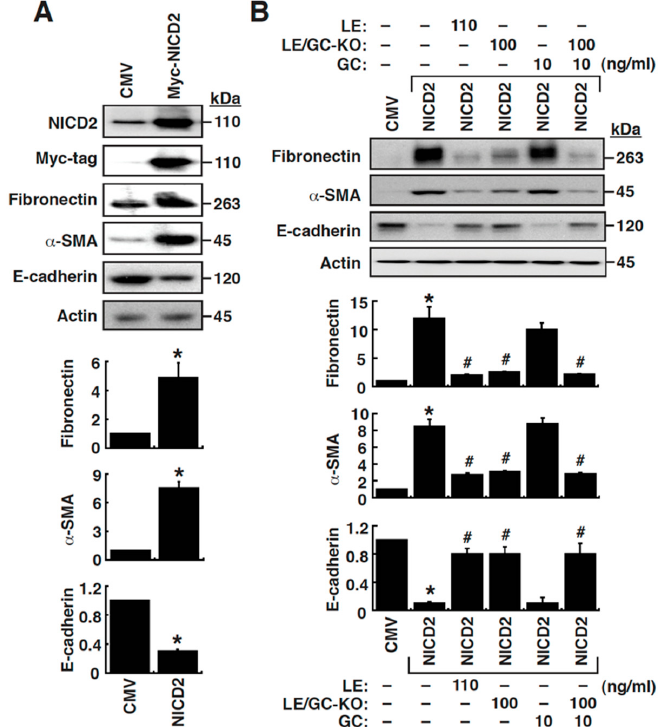
Figure 6. Overexpression of NICD2 is sufficient to induce EMT in NRK-52E cells; however, LE or LE/GC-KO can attenuate NICD2-mediated EMT. ( A ) Activation of EMT in NRK-52E cells by NICD2 overexpression. At 48 h of transfection, cells were harvested for Western blotting. * p < 0.05 versus the empty vector control ( n = 3). ( B ) Effect of LE, LE/GC-KO or GC on NICD2-mediated EMT in NRK-52E cells. At 48 h after transfection and treatment, cells were harvested for Western blotting. * p < 0.05 versus the empty vector control, # p < 0.05 versus untreated NICD2-transfected control ( n = 3).